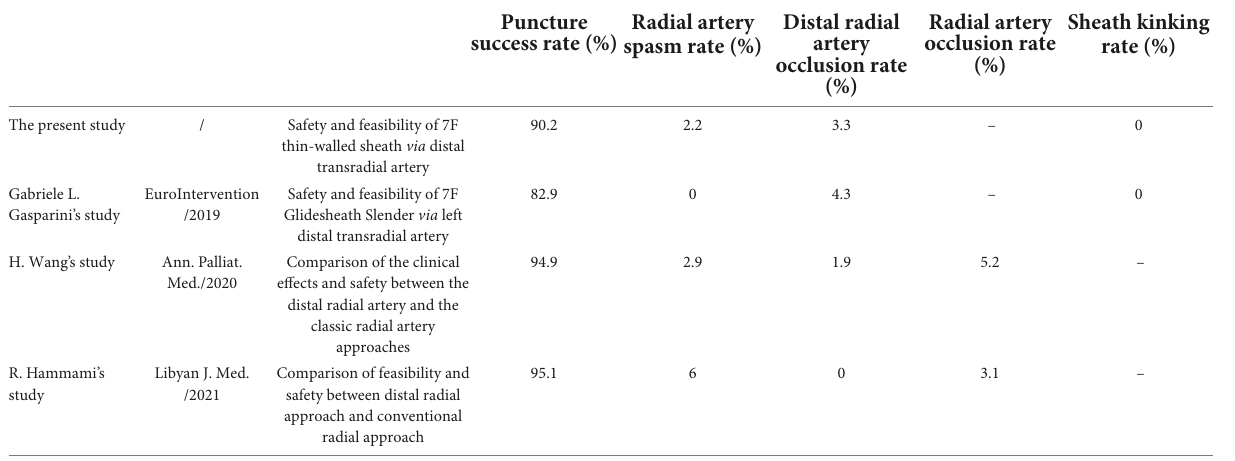
TABLE 6 Comparison between end-points of the present study and other studies. Study